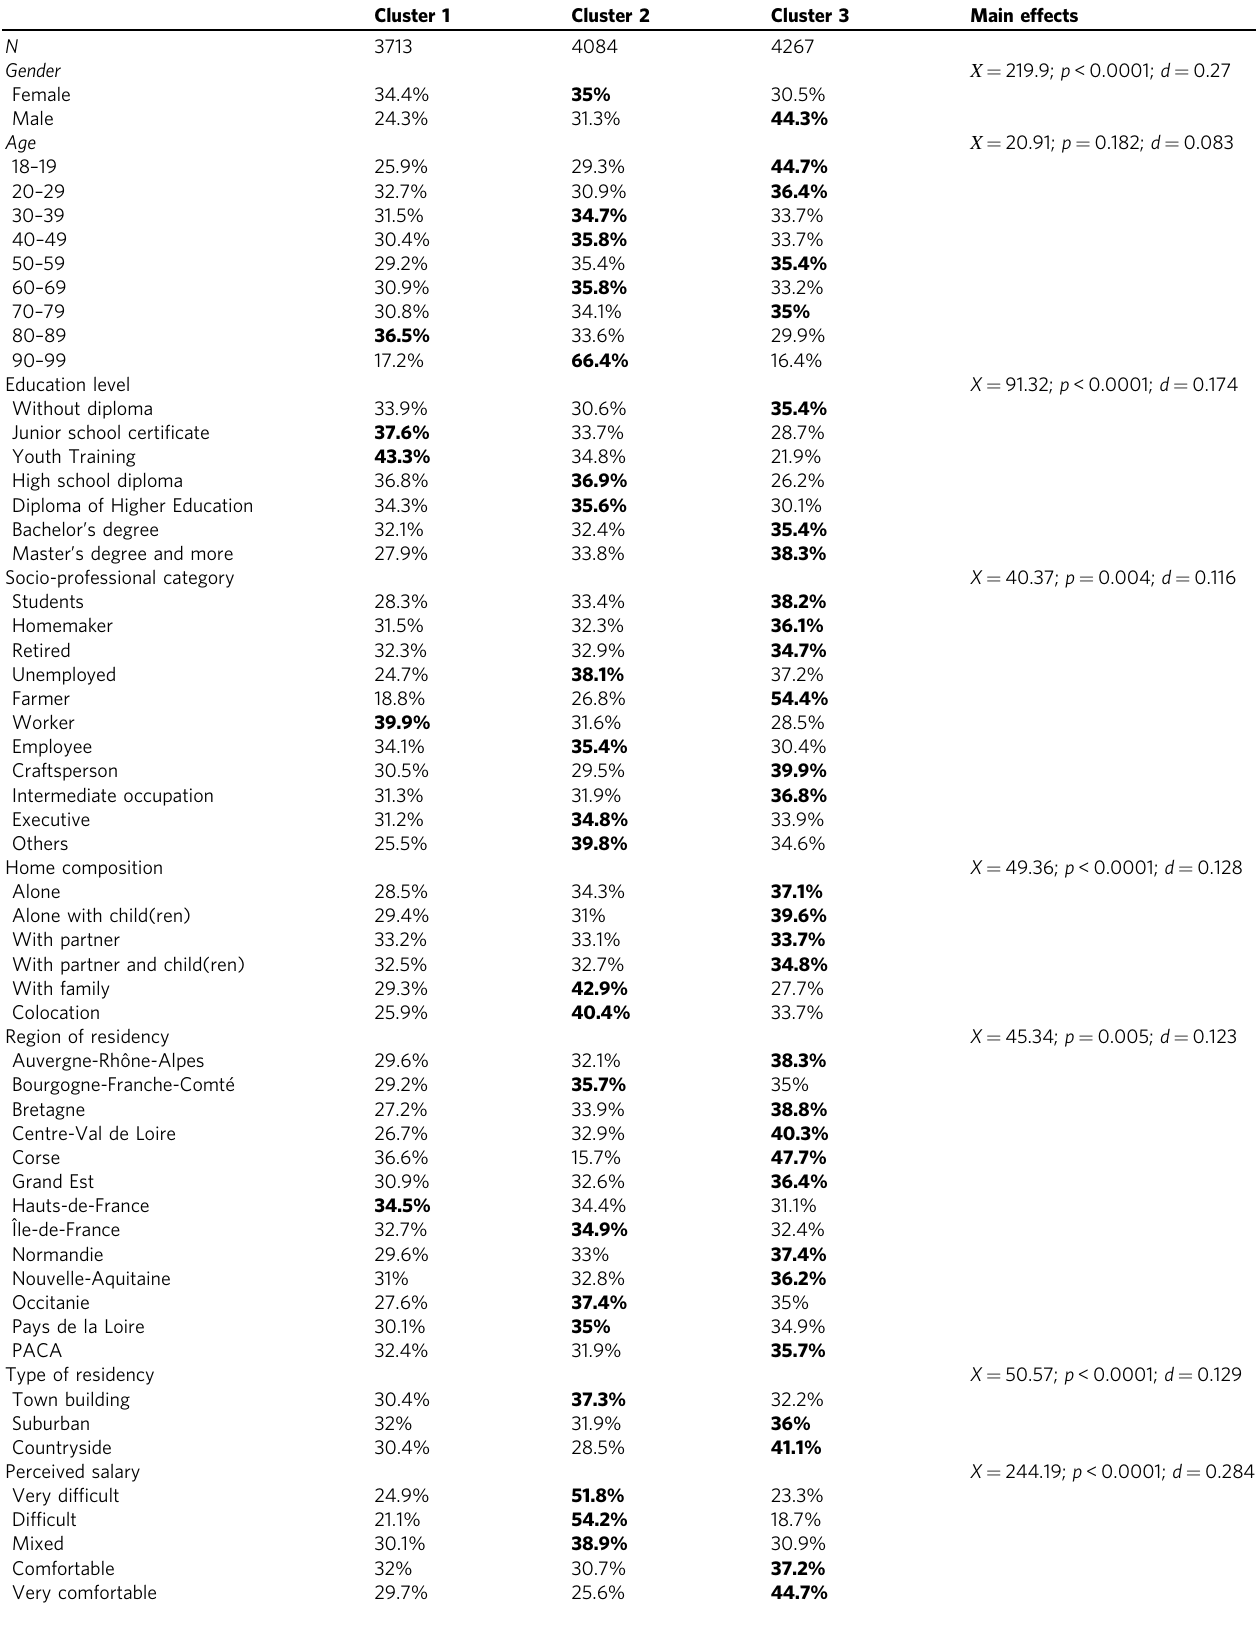
Table 3 Estimated probabilities to be in one of the three generated